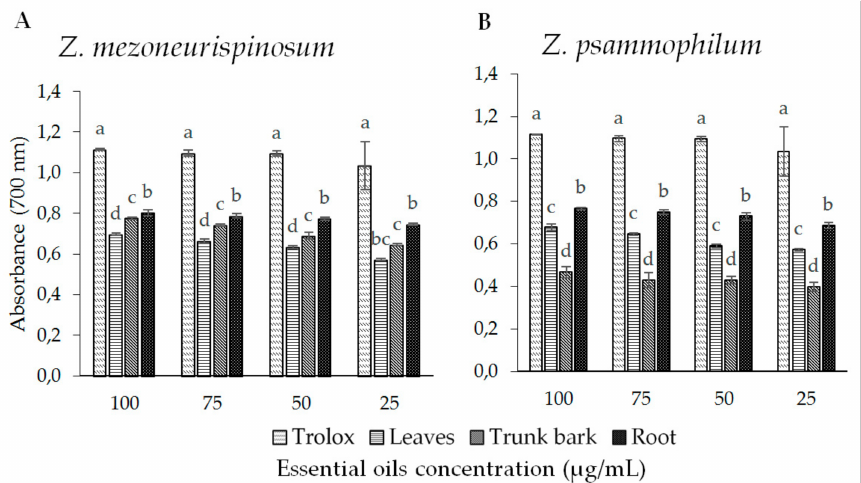
Figure 4. The ferric-reducing power of essential oils isolated from different organs of Z. mezoneurispinosum ( A ) and Z. psammophilum ( B ). Data are expressed as the mean and standard value, n = 3. Within a concentration, mean values followed by the same letter are not significantly di ff erent according to Tukey’s test ( p <